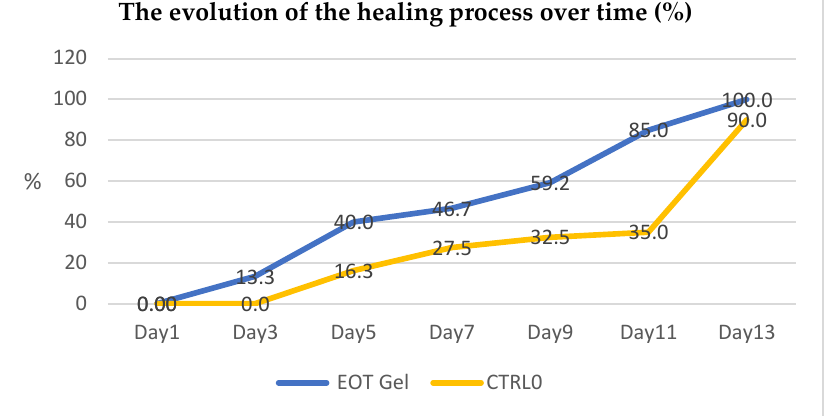
Figure 9. Evolution of the wound healing process in the case of EOT gel compared to control (CTRL0 — no treatment) as a function of time, expressed as a percentage (%).